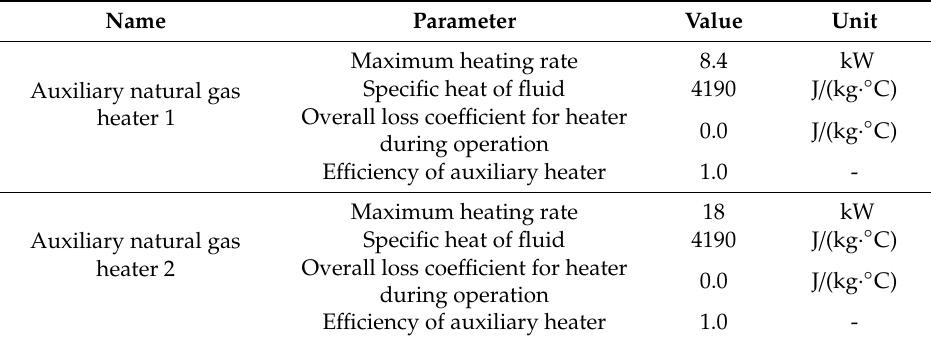
Table 8. Description of the auxiliary natural gas